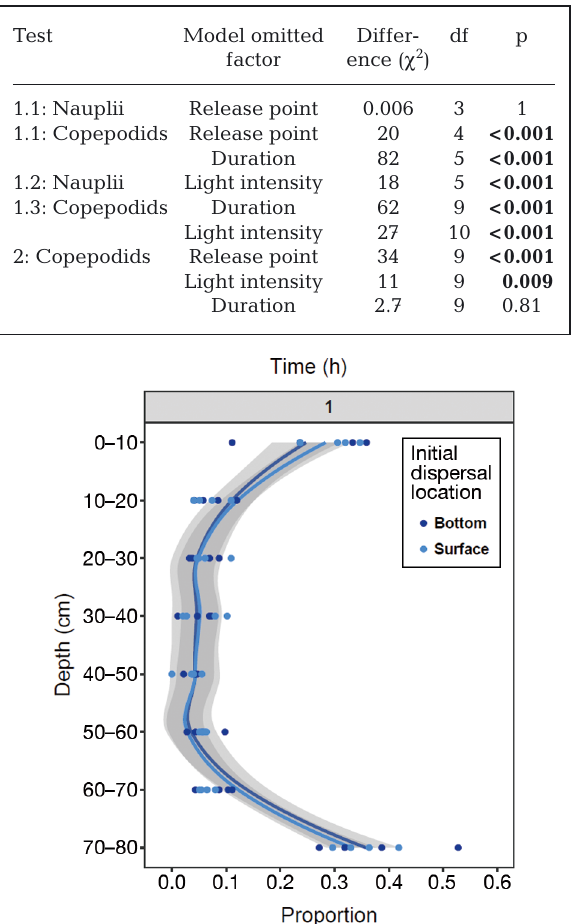
Fig. 3. Proportion of salmon lice Lepeophtheirus salmonis nauplii found in 10 cm increments within the column (0− 80 cm) exposed to 0 μmol m −2 s −1 after 1 h. Lice were released from either the surface or the bottom of the column at the beginning of the experiment. Points: individual data points; lines: smoothed loess average; shading: